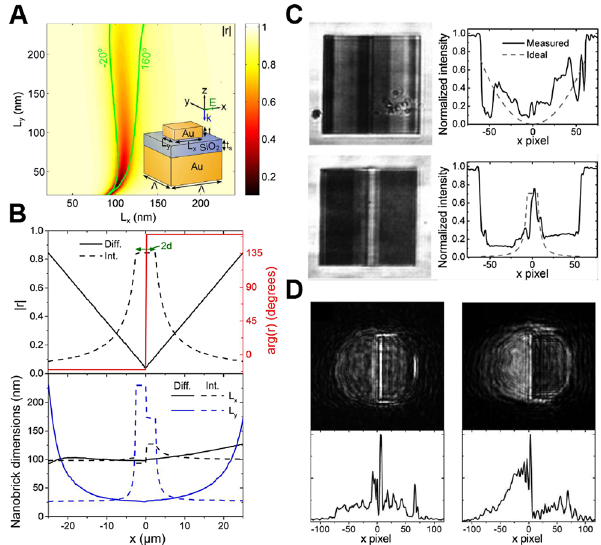
Figure 3: Reflective plasmonic metasurfaces for spatial analog signal processing [36]. (A) Color map of the calculated reflection coefficient as a function of the width of nanobricks for a reflective metasurface comprising an array of Au nanobricks on topof an Au substrateseparated witha thin oxide layer. Green curves indicate two contours of reflection phase with π -phasedifference.(B) Position-dependentreflectionamplitude/ phase profile (top panel) and the corresponding nanobrick width (bottom panel) for a 50- μ m-wide differentiator and integrator. (C) Bright-field images and the measured average normalized reflectivity from the metasurface realizing the transfer function of differentiation (top panel) and integration (bottom panel). (D) Reflected far-field intensity (top panel) and intensity profile averaged along the central part in the y -direction as a function of the x -coordinate (bottom panel) for the differentiator (left panel) and the integrator (right panel) system. Here, the excitation is through a bulky optical lens acting as Fourier and inverse Fourier subblocks